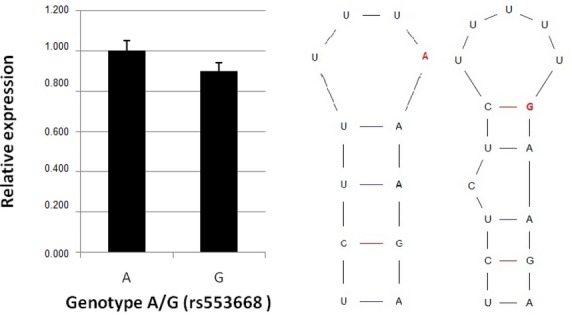
Left: relative expression of pOM-A and pOM-G plasmids. Right: Secondary structures formed by mRNA containing A (left structure) and G (right structure).